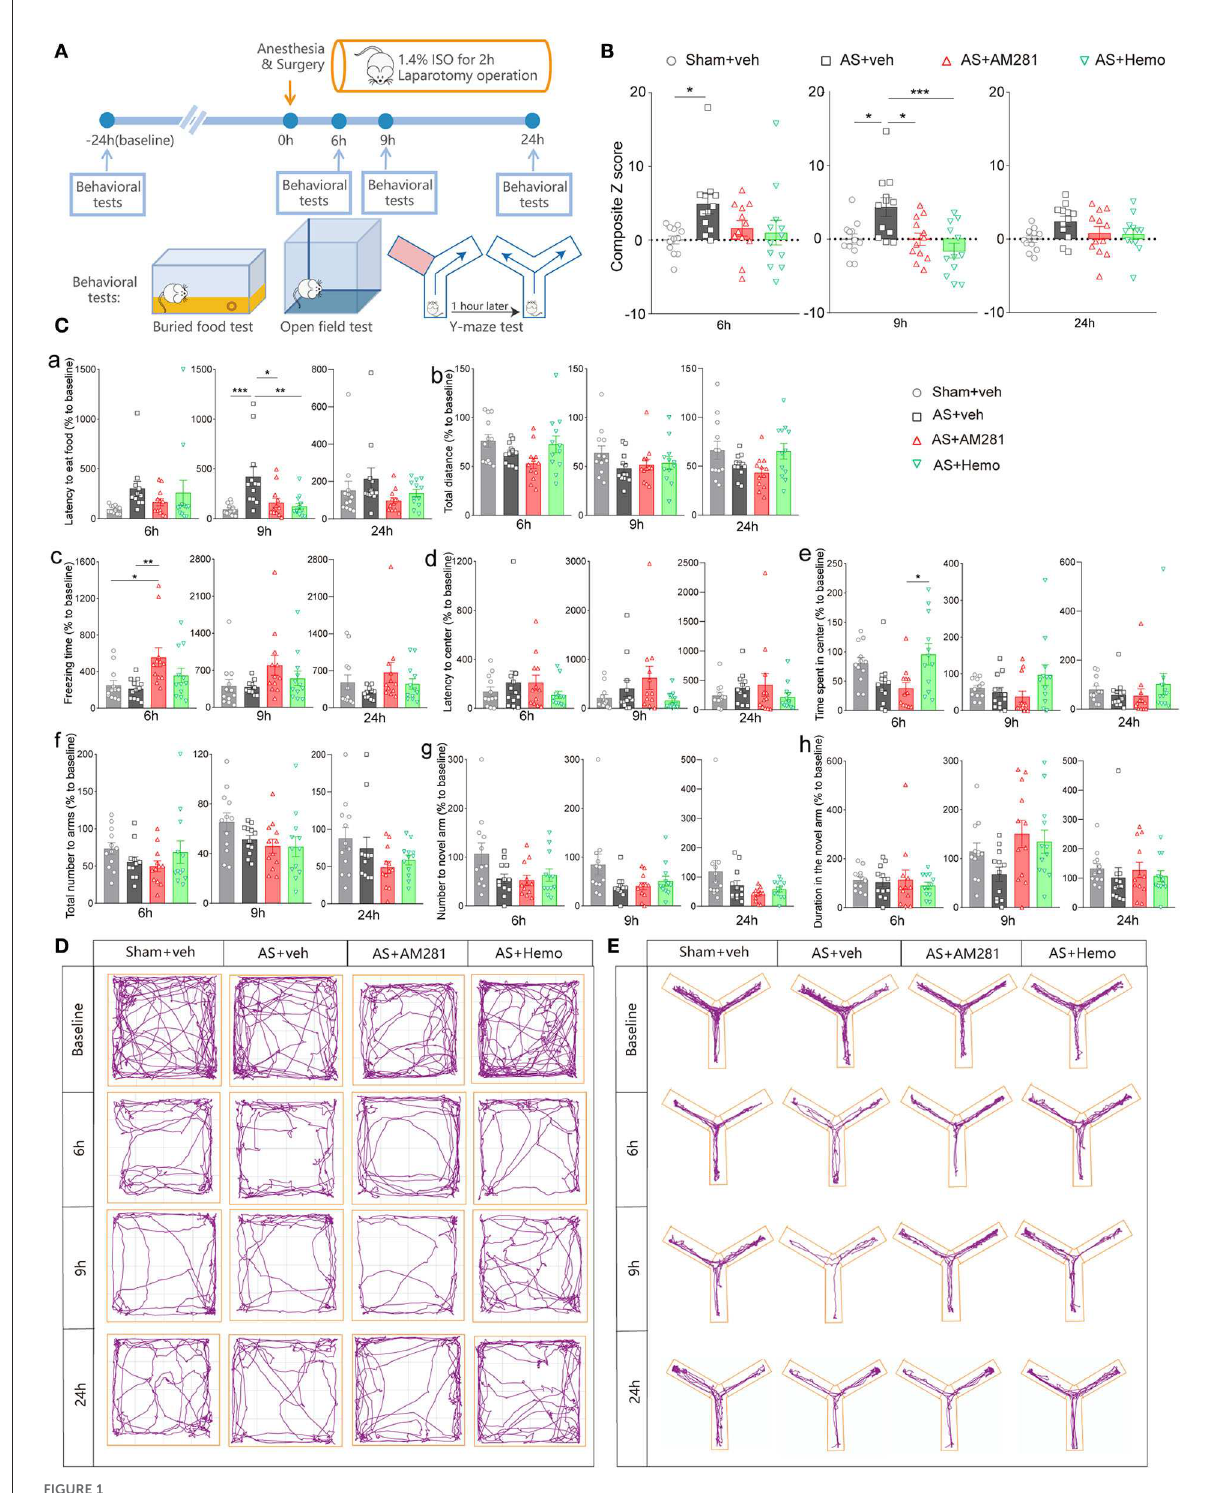
FIGURE1 Blockade of global CB1R alleviated POD. (A) Scheme of the experimental design. (B) The composite Z score at 6h (left), 9h (middle), and 24h (right) after AS. (C) The latency to eat food in buried food test (a); the total distance (b), the freezing time (c), the latency to center (d), time spent in center (e) in the open field; the total number to arm (f), number to novel arm (g), duration in the novel arm (h) in Y maze at 6h (left), 9h (middle), and 24h (right). (D,E) Running tracks of the mice in an open field (D) and Y maze (E) in groups. Data are shown as mean ± SEM. N = 12. * P < 0.05, ** P < 0.01, *** P < 0.001. ISO, isoflurane; AS, anesthesia and surgery; Hemo,